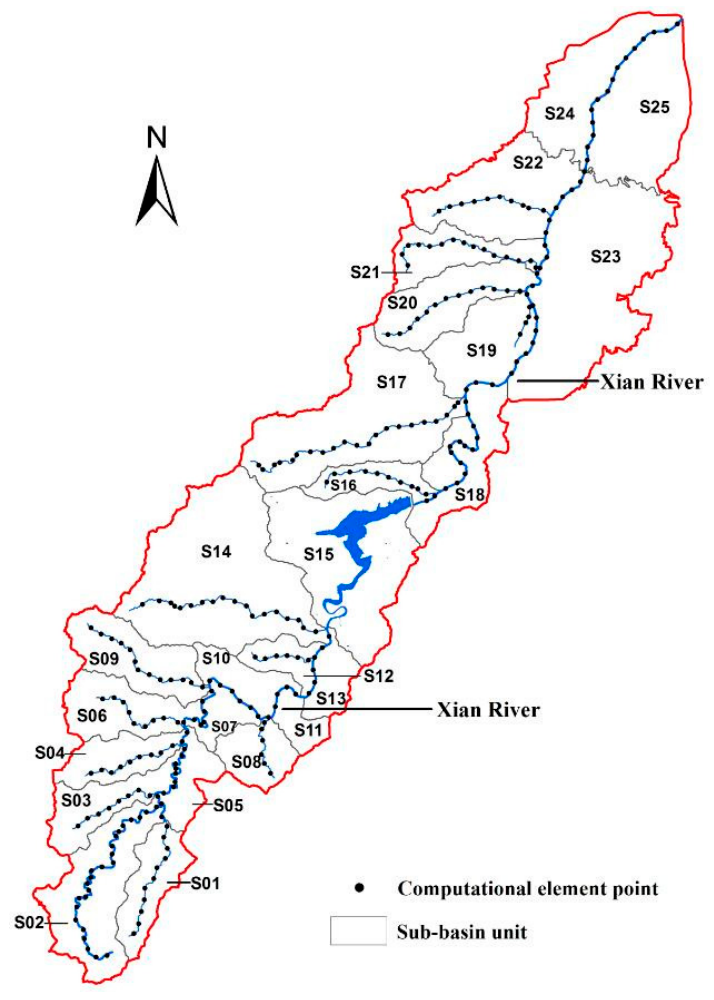
Figure 5. Sub-basin units and system elements number in the Xian-Jiang watershed.